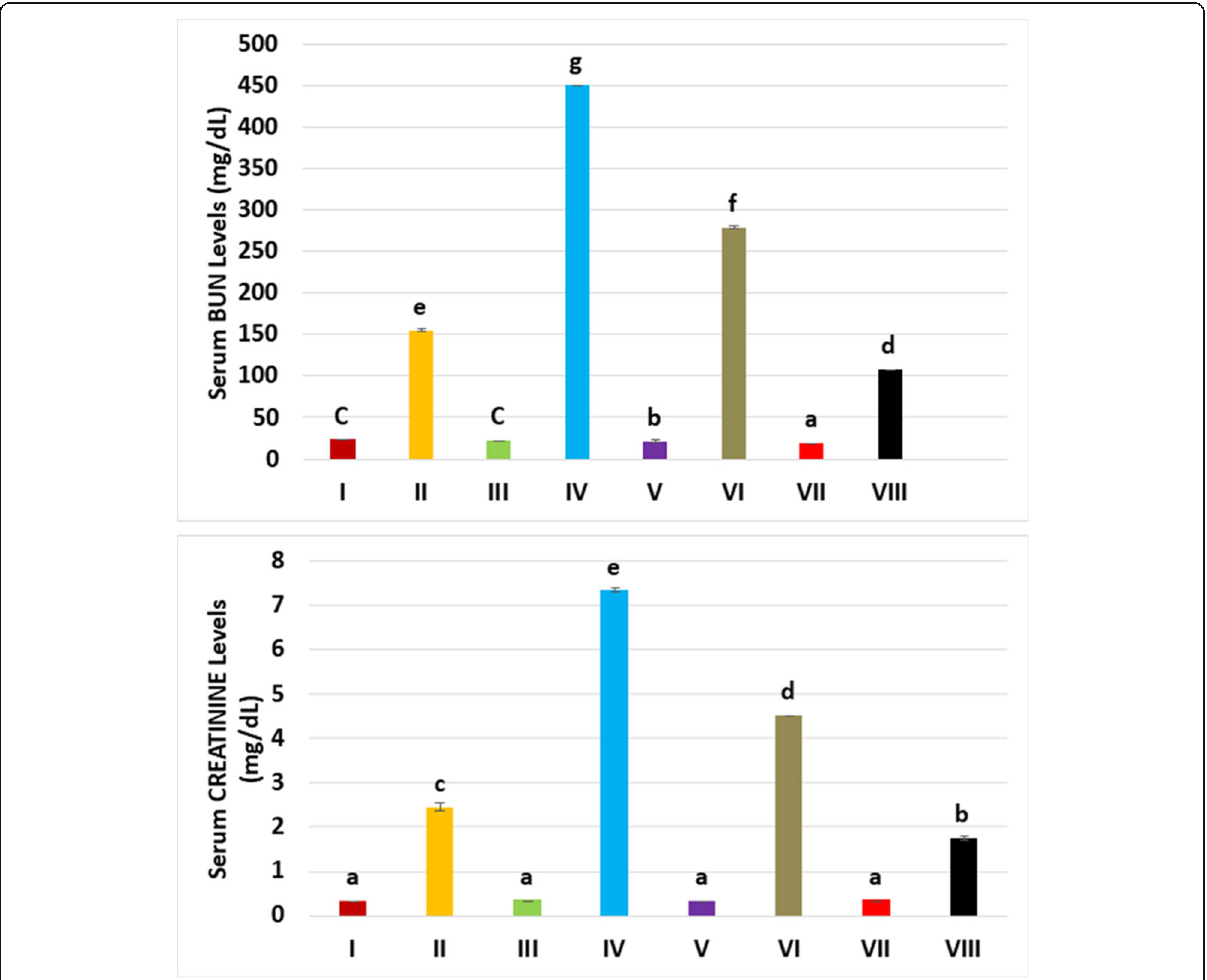
Fig. 2 The mean blood urea nitrogen (BUN) and creatinine levels for the experimental groups. Mean BUN level is the highest in group IV (glycerol plus contrast medium) and levosimendan administration lowered the levels of BUN. Serum creatinine levels showed similar trends with the administered drugs. Means in the same column with the same letter are not significantly different; means in the same column with different letters indicate the statistically significant differences between the groups.